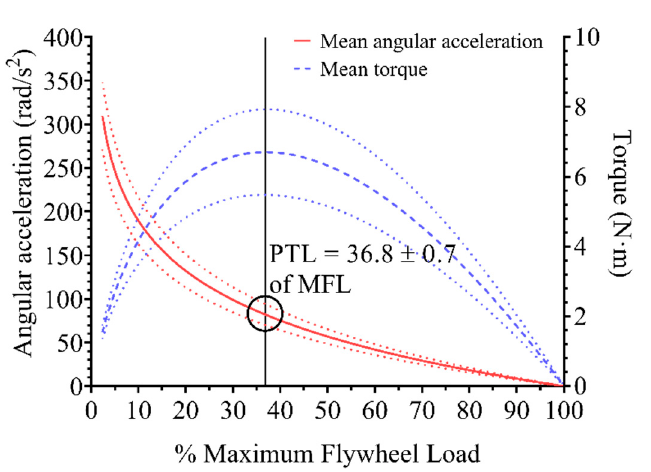
Figure 2. Association between mean angular acceleration and mean torque versus relative flywheel load. Lines represent mean ± standard deviation (dotted lines) of all the subjects’ individual regression lines (logarithmic fit for angular acceleration and second-degree polynomial for mean torque). The vertical black line represents the relative inertia at which peak torque load (PTL) is attained as a function of maximum flywheel load (MFL).